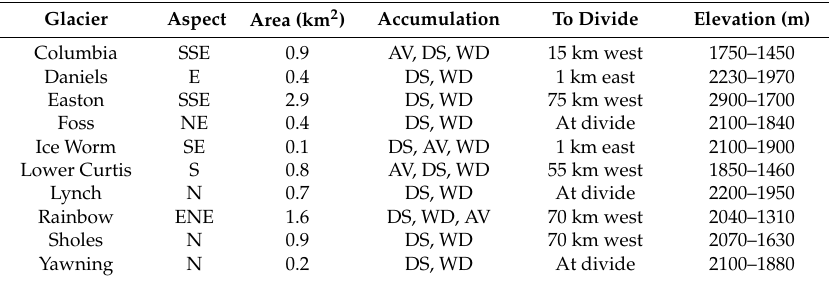
Table 1. The geographic characteristics of the nine glaciers where the annual balance has been monitored annually (Figure 1). Accumulation sources are listed in order of significance: wind drifting = WD, avalanche accumulation = AV, direct snowfall =